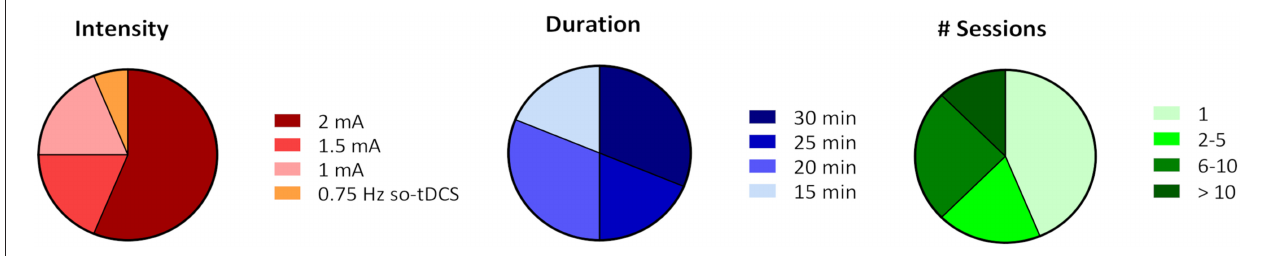
FIGURE 2 | Relative comparison of tDCS parameters intensity, session duration, and session number (# session) chosen in the 16 reviewed studies. Percentages were calculated based on the number of studies that chose a certain parameter out of the total number of 16 studies and do not resemble relative frequencies based on the number of subjects.